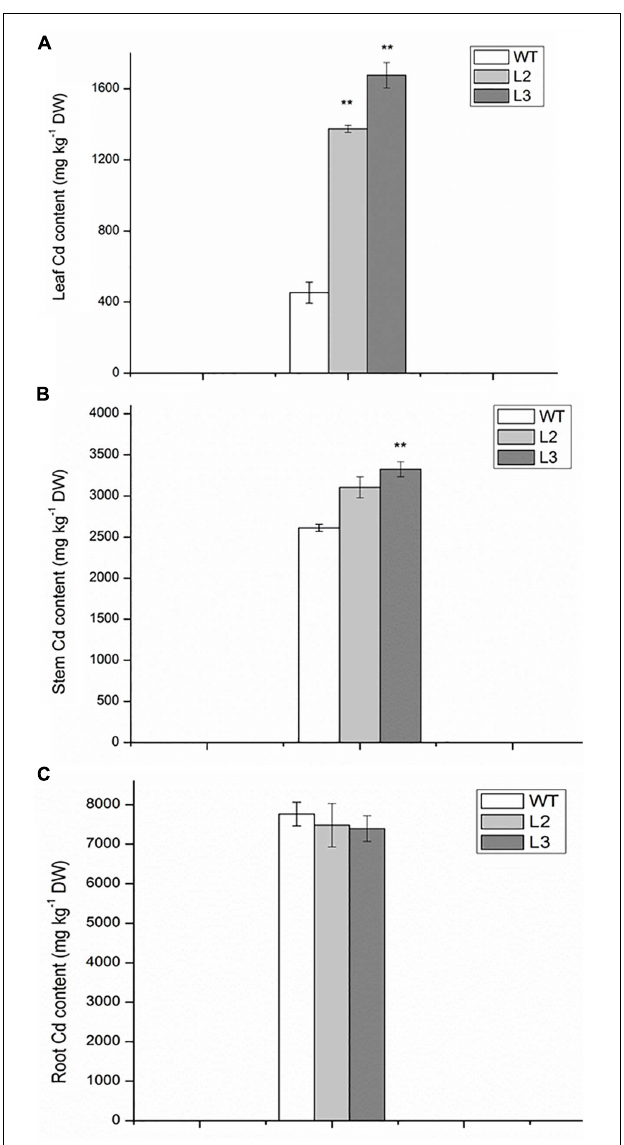
FIGURE 6 | The contents of Cd in leaves (A), stems (containing leaf sheaths) (B) and roots (C) of wild-type and transgenic plants exposed to 150 mM CdCl 2 for 14 days. Data are presented as the mean ± SD; ∗∗ indicates significant differences at P < 0.01 between wild-type and transgenic plants.